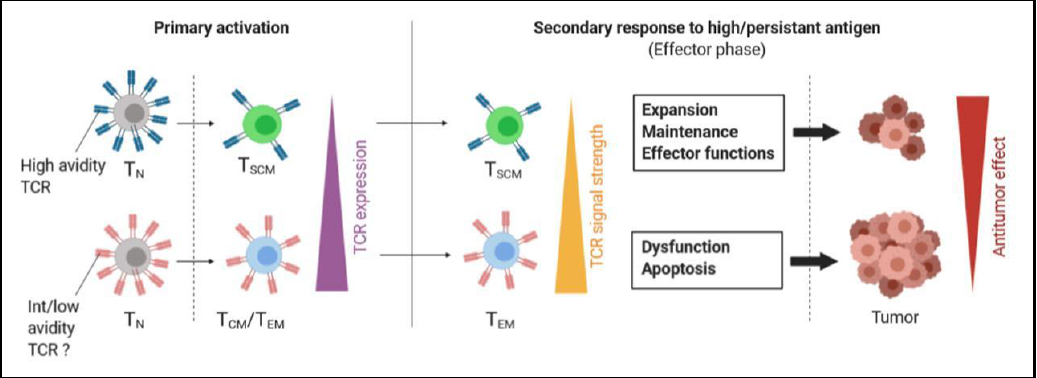
Figure 3. T SCM and T CM /T EM express distinct T-cell receptor (TCR) clonotypes that are differently regulated to respond to high/persistent antigen. T SCM are preferentially differentiated from naïve T cells with high avidity TCR clonotypes, and their primary activation drives a drastic downregulation of their TCR. Compared to conventional memory T cells, this results in the triggering of low TCR signals, which allows T SCM to maintain an efficient antitumor response in the presence of persistent antigens during the effector phase. T N , naïve T cell; T SCM , stem-cell like memory T cells; T CM : central memory T cell; T EM , effector memory T cell.